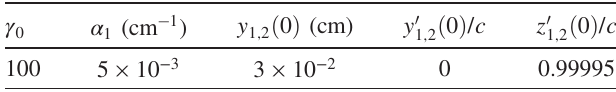
particle (red) versus particle longitudinal coordinate z 1